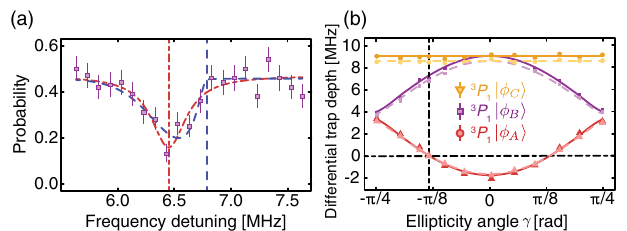
FIG. 7. Differential trap depth spectroscopy. (a) Spectroscopy signal measured on the 1 S 0 ↔ 3 P 1 j ϕ transition for the non- B i magic ellipticity angle γ ¼ 28 °. The signal is fitted to a purely thermally broadened line shape (blue dashed curve) and to a purely power broadened line shape (red dash-dotted curve). The vertical lines indicate the position of the edge frequency (blue dashed line) and center frequency (red dash-dotted line). We expect the true rescaled differential trap depth to lie between these two values as a combination of power and thermal broadening determines the true line shape. (b) Differential trap depth measured on the three 1 S 0 ↔ 3 P 1 transitions for various ellipticity angles assuming a thermally broadened line shape (dark markers) and a power broadened line shape (light markers). The measured values are simultaneously fitted to the analytical solution of the eigenvalues of the Stark Hamiltonian with three free parameters. At the magic ellipticity angle j γ j ¼ 24 ° (black dash-dotted line), the differential trap depth on the 1 S 0 ↔ 3 P 1 j ϕ transition A i